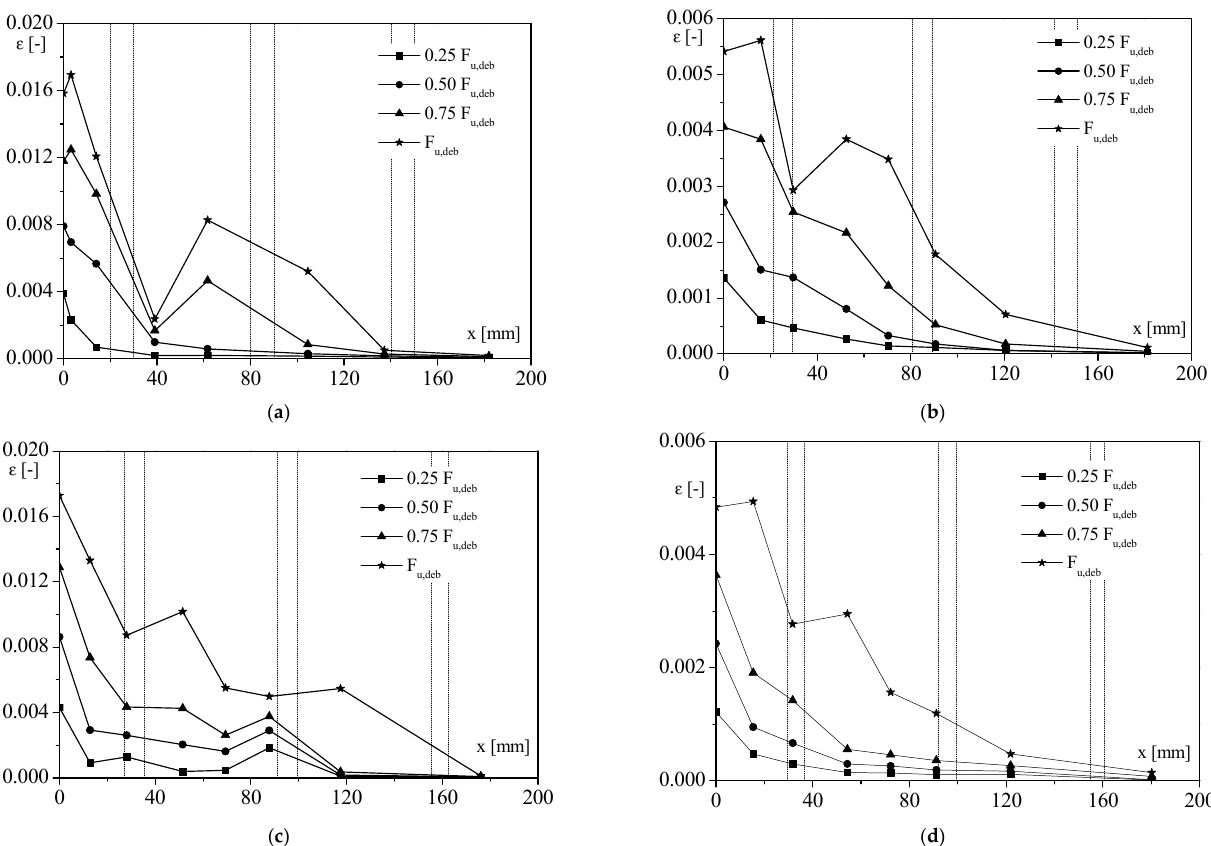
Figure 7. Strain distribution for samples with clay masonry unit substrate: ( a ) MB-B1-2; (b ) MB-C1-2; ( c ) MB-G1-3; ( d ) MB-S-3.